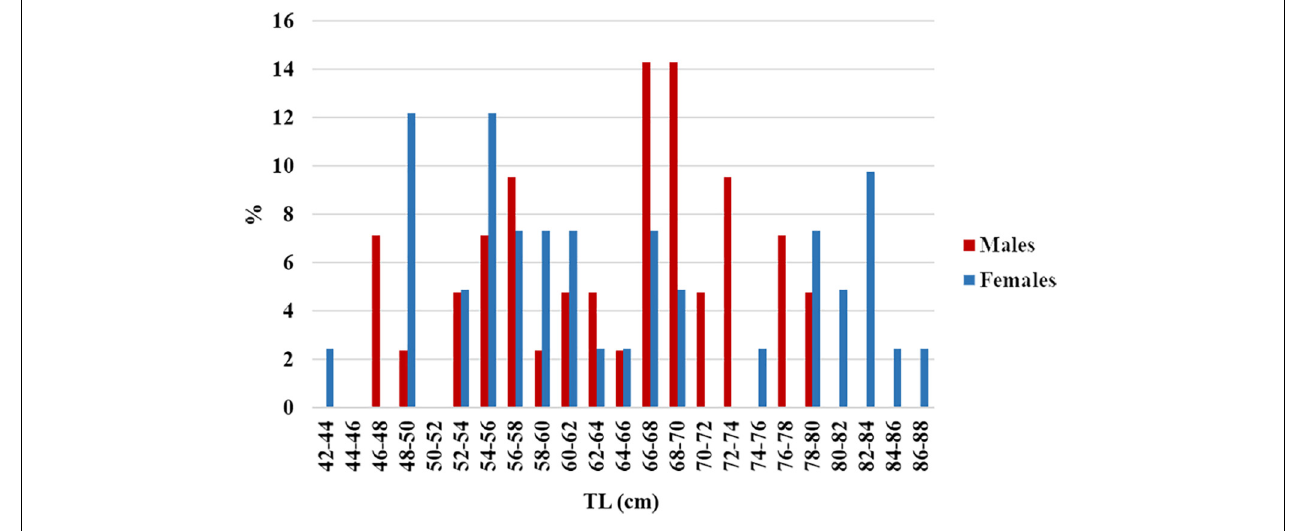
FIGURE 10 | Length frequency distribution of the tagged specimens.